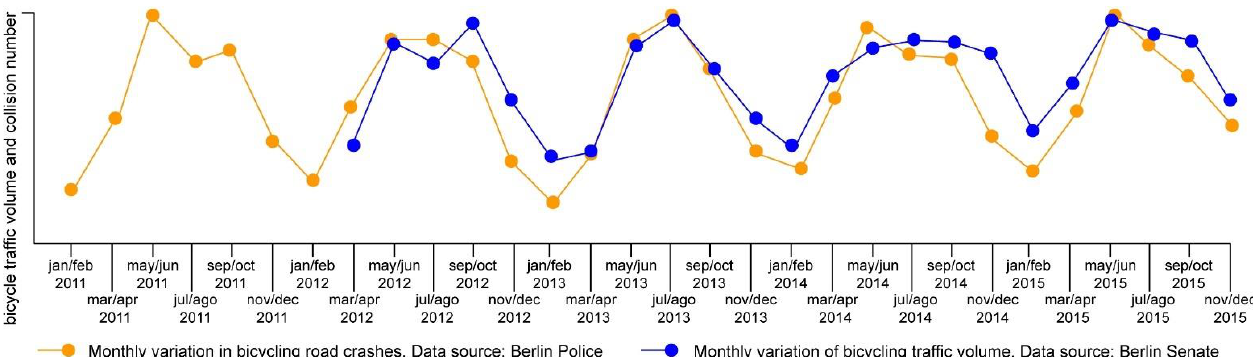
Figure 8. Temporal variation in bicycle traffic volumes and bicycle collisions. Variable values at peak are normalized in the y axis plot. Data sources: Berlin Police, Berlin Senate. Figure source: the authors.